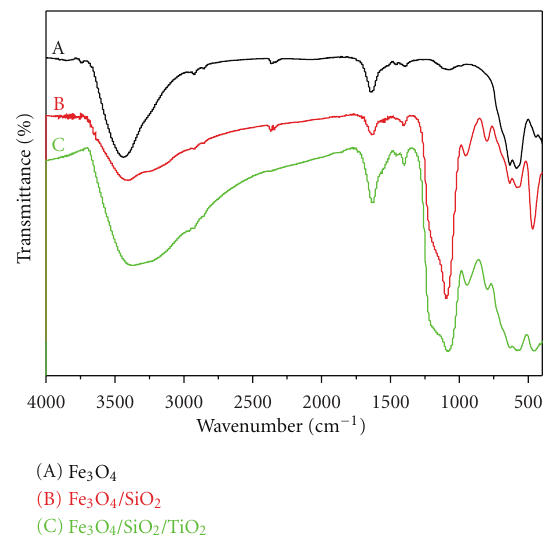
Figure 2: FT-IR spectra of Fe 3 O 4 (A), Fe 3 O 4 /SiO 2 (B), and Fe 3 O 4 /SiO 2 /TiO 2 composites